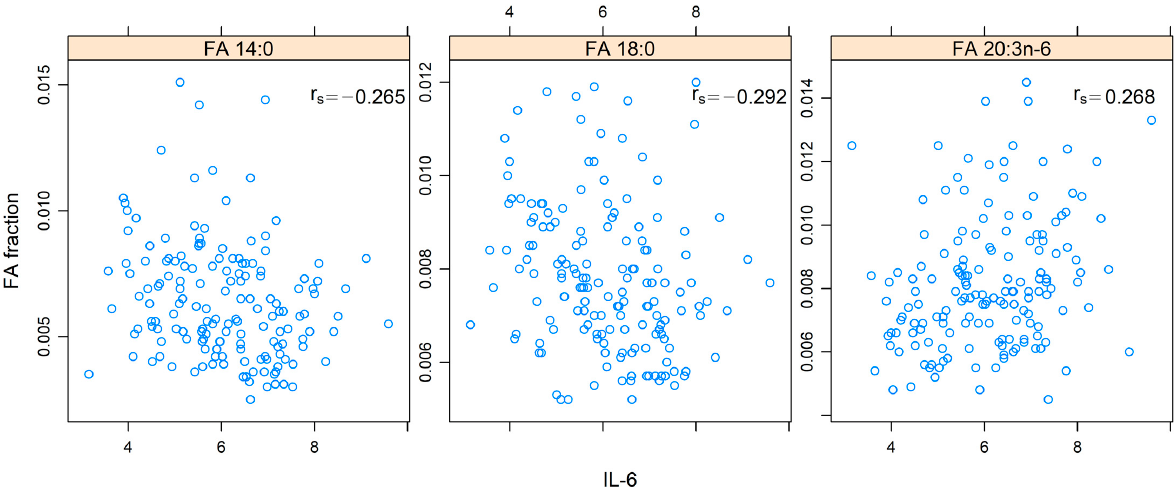
Figure 5. Spearman´s rank correlation (r s ) of fatty acids (FAs) 14:0, 18:0, and 20:3n-6 and interleukin 6 (IL-6) at 7 weeks in patients with head and neck cancer. The values for the FAs are presented in relation to the total amount of FAs. The values of IL-6 are presented in log-2 scale on the x -axis. At 1 year, IL-6 showed a positive correlation with 16:0 (r s = 0.278, p -adj = 0.033) and a negative correlation with 18:2n-6 (r s = − 0.272, p -adj = 0.042), as shown in Figure 6.